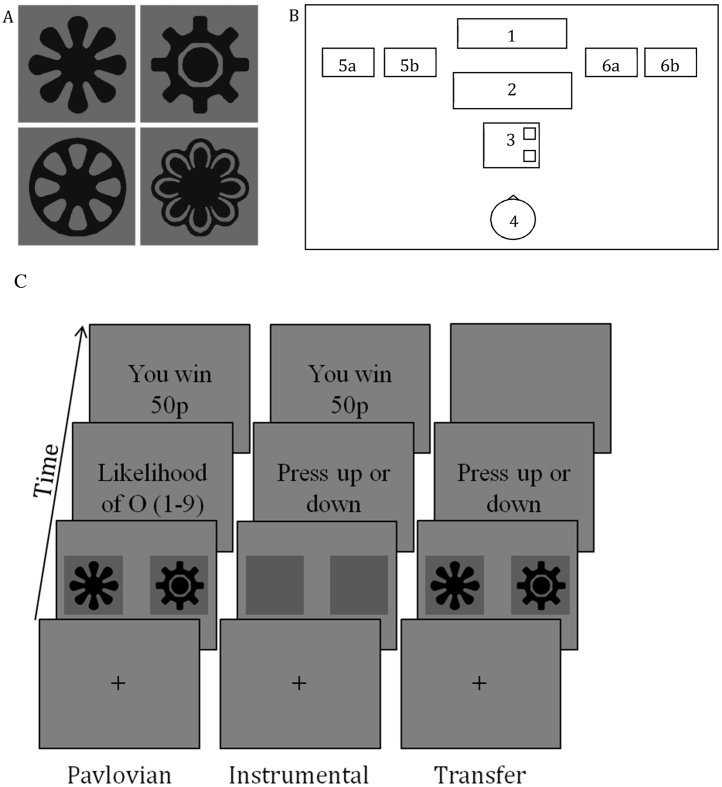
Stimuli used in Pavlovian and transfer phases of the experiment [A], layout of apparatus within cubicle, aerial view [B] and Diagram of PIT procedure [C]; Pavlovian. Trials began with a fixation cross for duration 1s. This was then replaced by a stimulus pair (CS; 3 s). The outcome (O) expectancy question then appeared with anchors “1 = 10p, 5 = don't know, 9 = 50p”. Upon response a grey screen appeared (1s; not shown), followed by an instruction to “Press the spacebar to find out how much you have won” (not shown). Immediately after pressing the spacebar participants were informed of the outcome (10p/50p; 2s), which was contingent solely upon the CS displayed (and so not dependent on a correct response to the expectancy question). Instrumental. Trials began with a fixation cross (1s). Then a pair of identical dark grey squares (distinguishable from the lighter background) appeared (2s). This was followed by a screen prompting participants to select a response, after which came a reinforcement screen (10p/50p; 2s). Transfer. Transfer was similar to instrumental training. However, grey squares appeared in only ⅓ of trials, with the remaining ⅔ split equally between CS10 and CS50 trials; also the reinforcement screen was replaced by a blank screen (1s). 1 = LCD screen; 2 = keyboard; 3 = response box; 4 = participant; 5a/b = 10p/50p coin box; 6a/b = participant’s 10p/50p winnings box. Note that keyboard and response box were both placed in the location of 3–keyboard during Pavlovian training, response box during instrumental training and transfer.